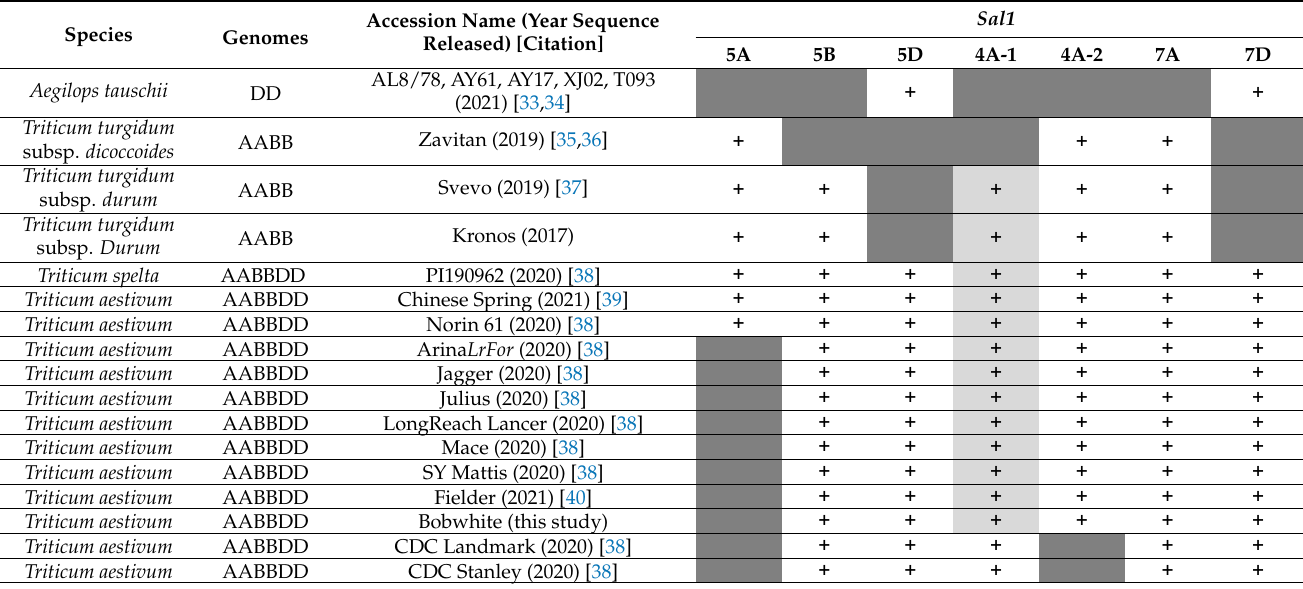
Table 1. The Sal1 gene family in wheat and wheat